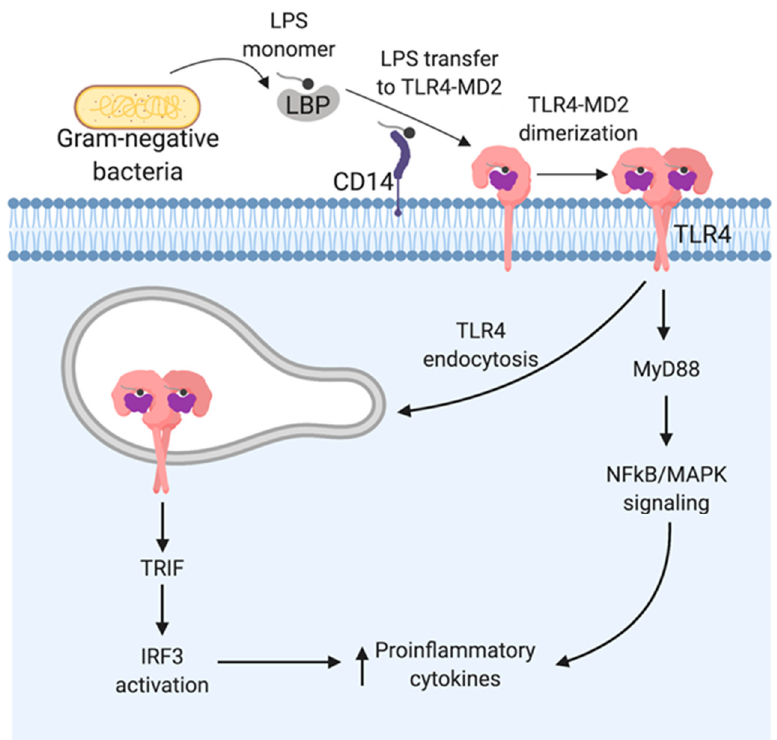
Figure 2. LPS recognition by toll-like receptor 4 (TLR4). Serum protein LBP (LPS-binding protein) binds monomer of LPS from Gram-negative bacteria and delivers it to a CD14 molecule that can be either soluble or membrane-bound (glycosylphosphatidylinositol-anchored protein). CD14 transfers LPS to the ectodomain of the TLR4/MD-2 receptor complex which leads to homodimerization of TLR4. This change in conformation leads to dimerization of the cytoplasmic TIR-domain (Toll- interleukin-1 receptor) that provides a binding site for MyD88. This activates the transcription factor nuclear factor- κ B (NF- κ B) and MAPK (mitogen-activated protein kinase) and transcription of various proinflammatory cytokines. In addition, the endocytosis of the LPS-TLR4/MD-2 complex leads to the TRIF-dependent signaling pathway that mediates the induction of interferon regulatory factor 3 (IRF3) and type-1 interferons.